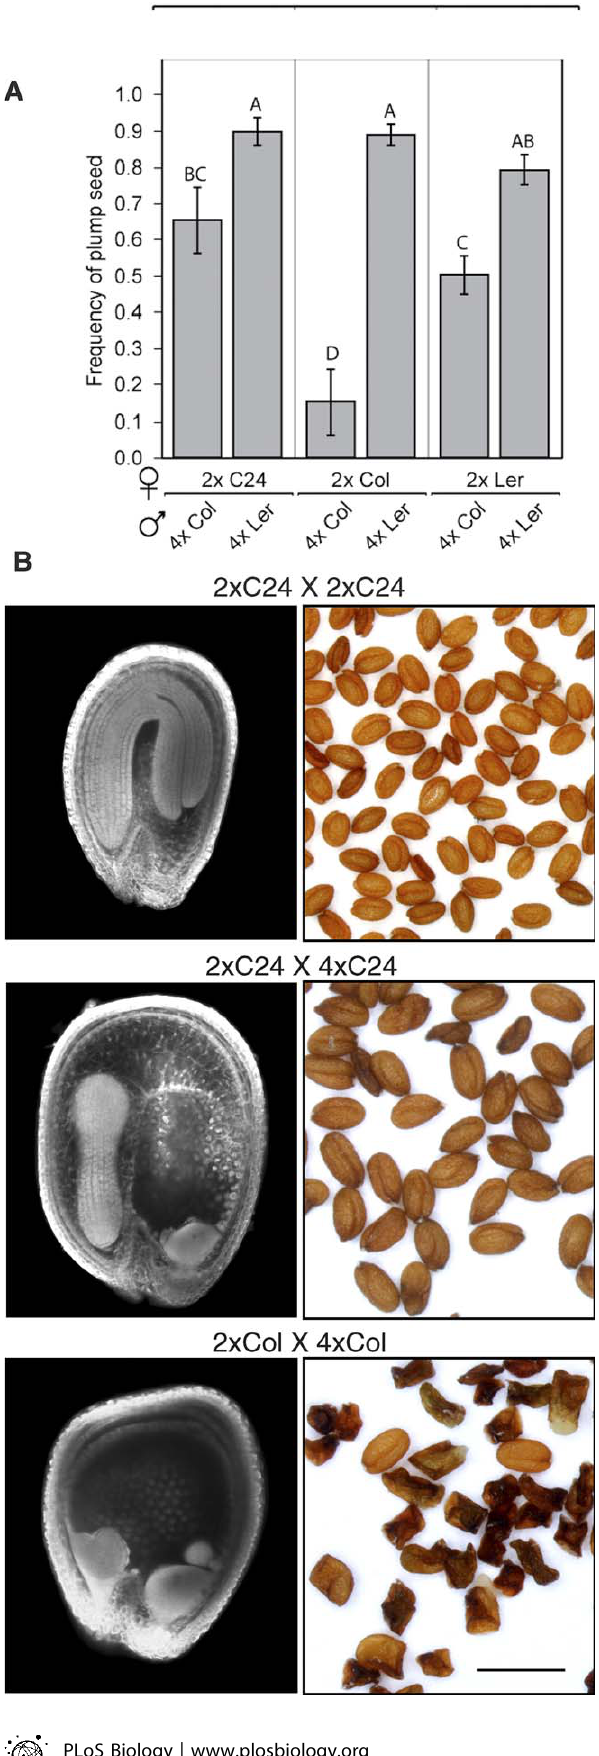
Figure 1. Arabidopsis Strains Vary in the Frequencies of Seed Death in 2x 3 4x Crosses ( A) Genetic background determines seed survival in interploidy crosses. Diploids from Arabidopsis accessions Ler, Col-0, and C24 were crossed as seed parents to tetraploid derivatives of Ler and Col. The frequency of plump seeds in the progeny of these crosses ( y -axis) was determined and the mean for each cross is given along with the standard error. Shared letters above the histogram indicate genotypes that were not different by Student t -test at p , 0.05. (B) Confocal laser-scanning photomicrographs of developing seeds at 7 DAP (left) and photomicrographs of mature seeds (right) from 2x C24 3 2x C24, 2x C24 3 4x C24, and 2x C24 3 4x Col. Adding paternal genomes by crossing with a 4x pollen parent caused a delay in embryo development and increased the size of endosperm and seeds. In the crosses to 4x Col, overgrowth of the endosperm and aberrant cellularization are evident in the embryo-surrounding region and peripheral endosperm (left panel), and most seeds abort (right panel).